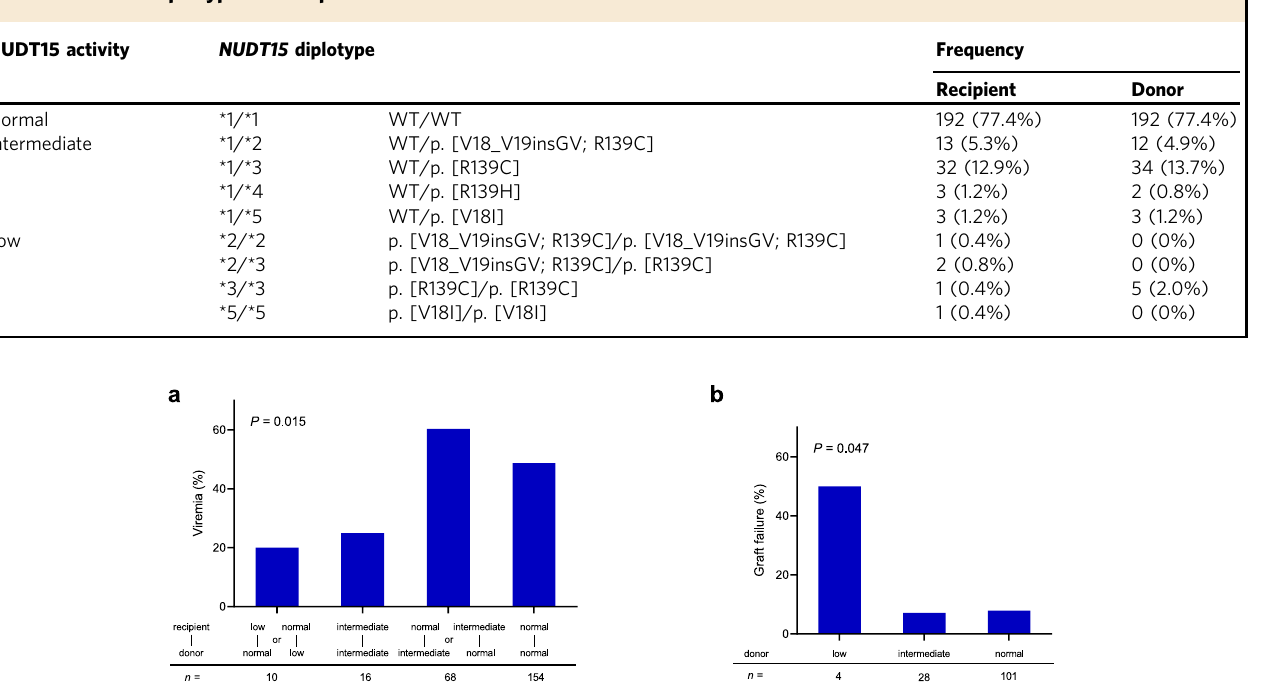
Fig. 4 Effects of NUDT15 on cytotoxicity of acyclovir (ACV) and ganciclovir (GCV) in host hematopoietic cells expressing viral thymidine kinase (TK). Human hematopoietic cell line Nalm6 with NUDT15 WT or KO genotype were transduced at a low MOI (<0.2) with a HSV-TK lentiviral vector. Cells expressing HSV-TK were incubated with ACV or GCV at increasing concentrations for 72 h, and cytotoxicity was determined by CellTiter-Glo assay. Data represent the mean of three replicates; error bars, s.d. Two-tailed paired t -test was performed to compare WT with KO. Source data are provided as a Source Data fi le. Table 1 NUDT15 diplotypes in recipients and donors.